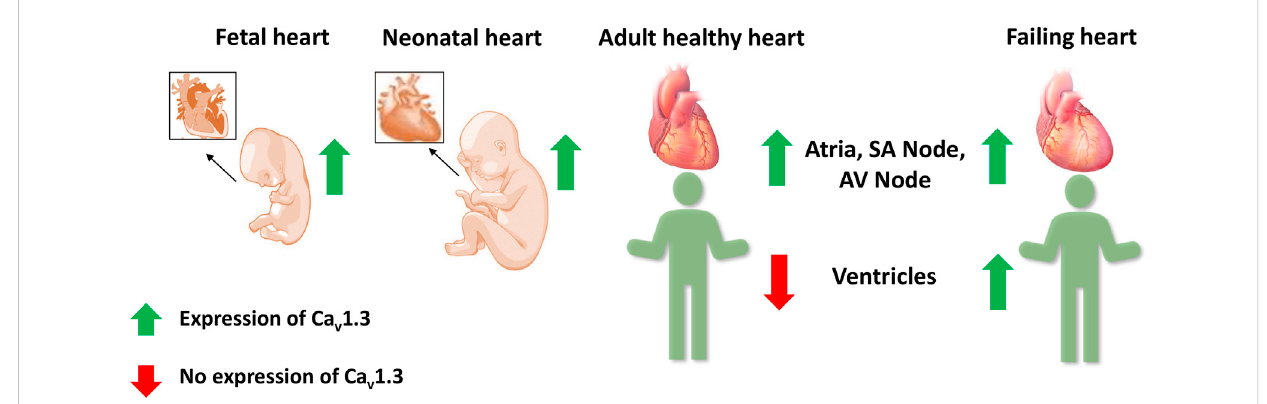
FIGURE 4 Expression of Ca v 1.3 L-type Ca 2+ channel in the fetal, neonatal, adult, and failing heart. Ca v 1.3 is expressed in the supraventricular and ventricular tissue of thefetal and neonatal hearts.However inadult hearts, it isexpressedonly intheatria, sinoatrial (SA) node, and atrioventricular(AV) node, but not in the ventricles. Recent evidence suggests a Ca v 1.3 de novo expression in the ventricles of adult failing